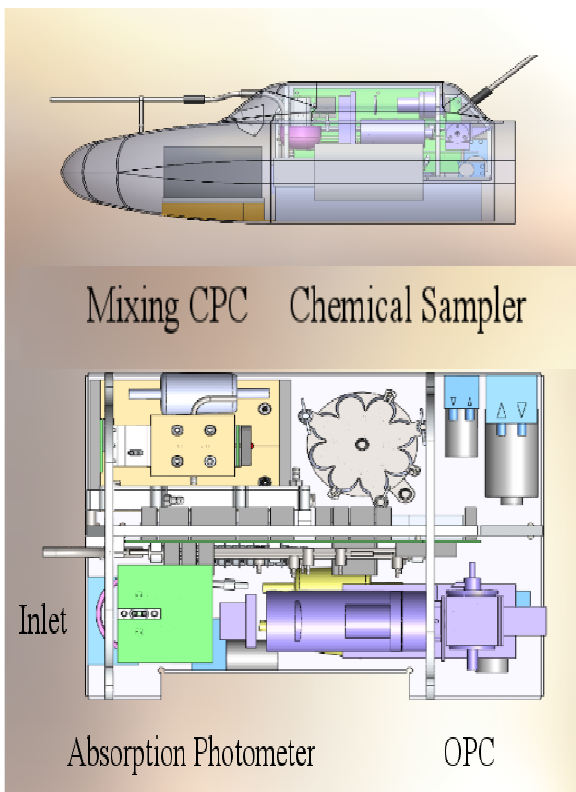
Fig. 2. Aerosol measurement package in the MANTA showing the inlet and exhaust lines, mixing condensation particle sam- pler (MCPC), 8-filter chemical sampler, and absorption photometer (ABS) flown during STADS. The optical particle counter was not available for the experiment.